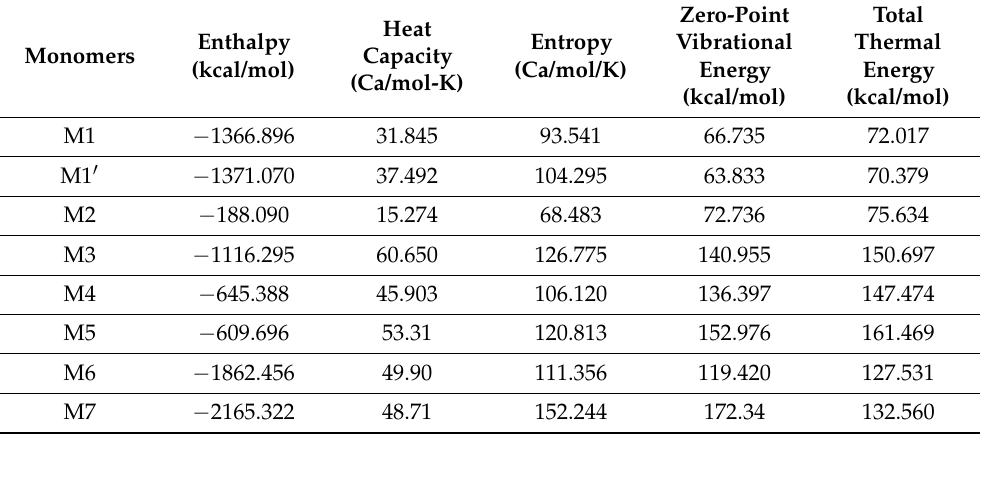
Table 5. Computed thermodynamic parameters of monomers and representative polymers at DFT/B3LYP/6-311G** (d, p) basis set.